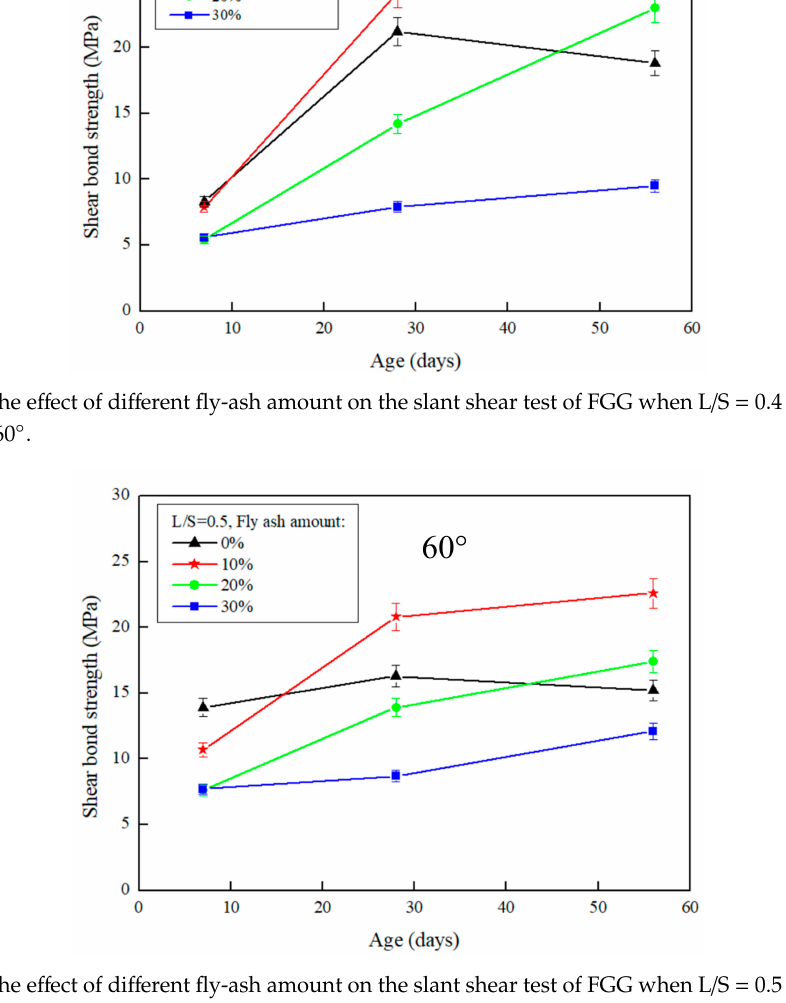
Figure 6. The e ff ect of di ff erent fly-ash amount on the slant shear test of FGG when L / S = 0.5 and repair angle was 60 ◦